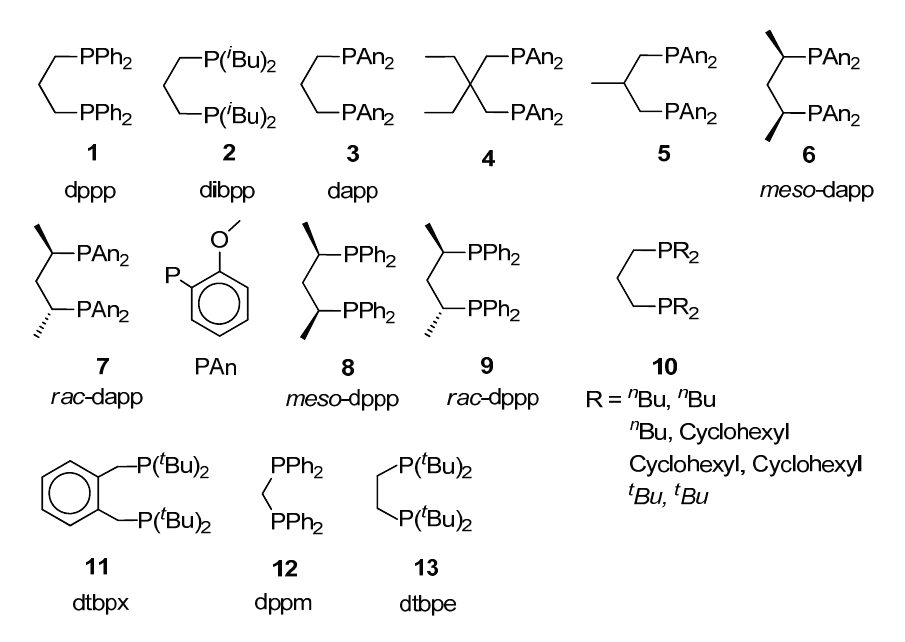
Figure 1. P-P ligands for the carbonylation of